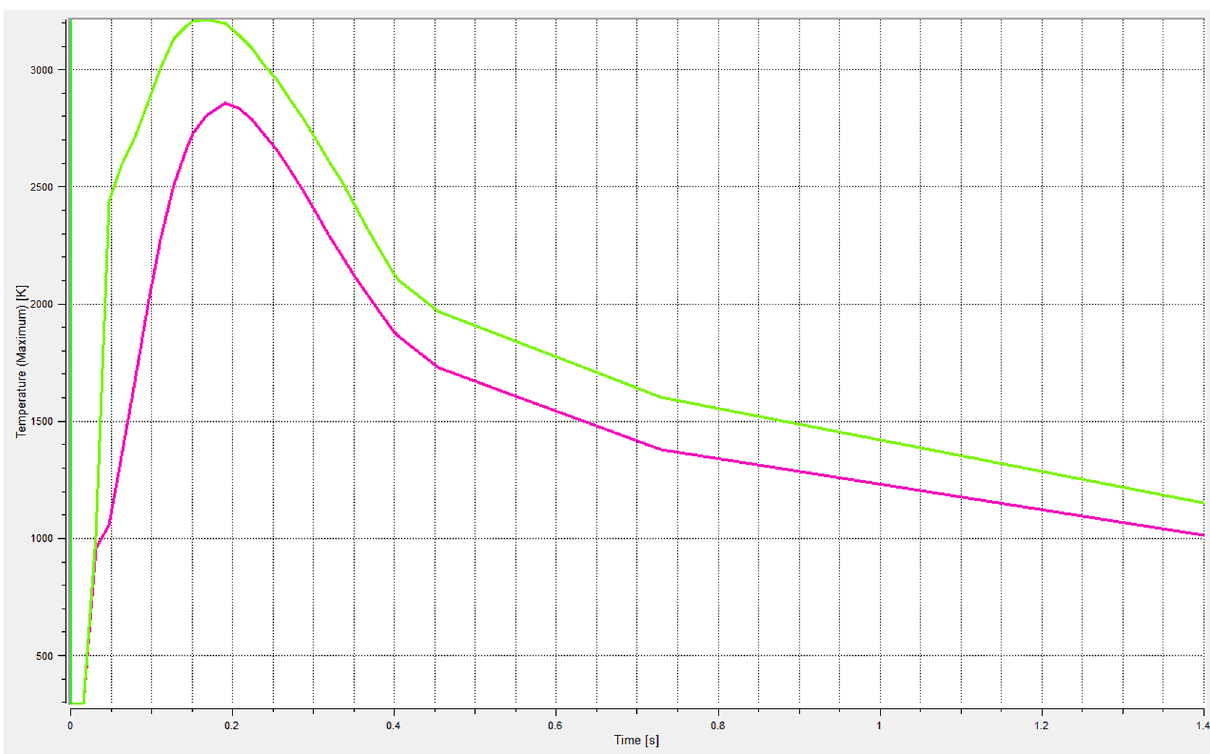
Fig. 10 Maximum temperature vs time for run no.3 at lower electrode (green), upper electrode (pink)